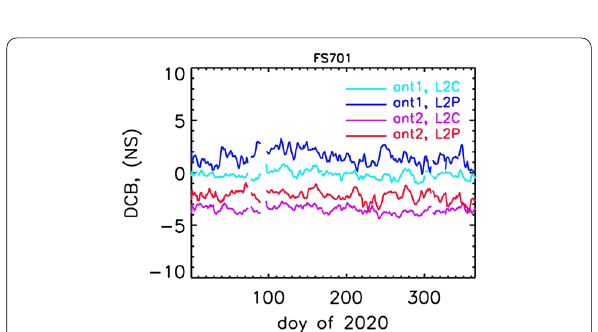
Fig. 6 DCB variations of GPS signal of FS701 satellite from day of year 001 to 365 in 2020. The green, blue, purple and red curves are for L2C signal of antenna 1, L2P signal of antenna 1, L2C signal of antenna 2, and L2P signal of antenna 2,